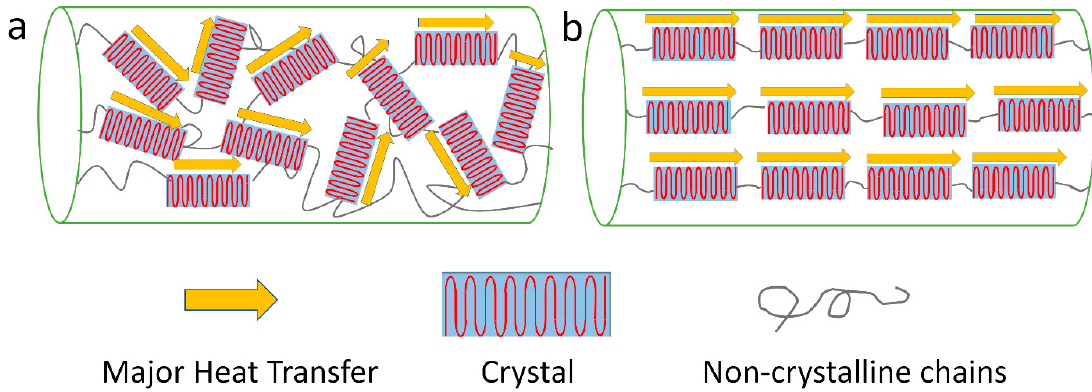
Figure 4. Effect of crystal alignment on heat transfer: ( a ) structure of bulk crystalized polymer with less crystal alignment; ( b ) structure of stretched crystalized polymer with good crystal orientation.